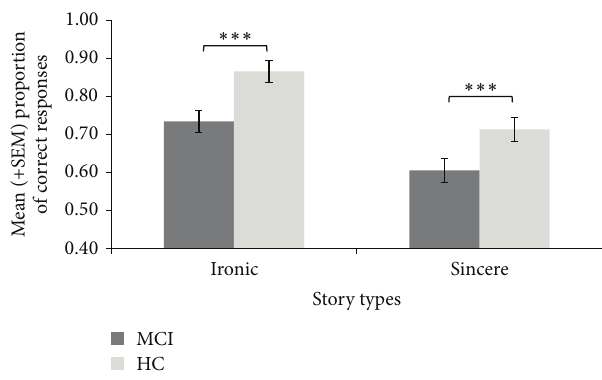
Figure 2: Mean proportions of correct responses ( ± SEM) for ironic and sincere stories of the Short Scenario Irony Comprehension Task. MCI = elderly persons with mild cognitive impairment; HC = healthy control participants; SEM = standard error of the mean ∗∗∗ 𝑝 < 0.001 .